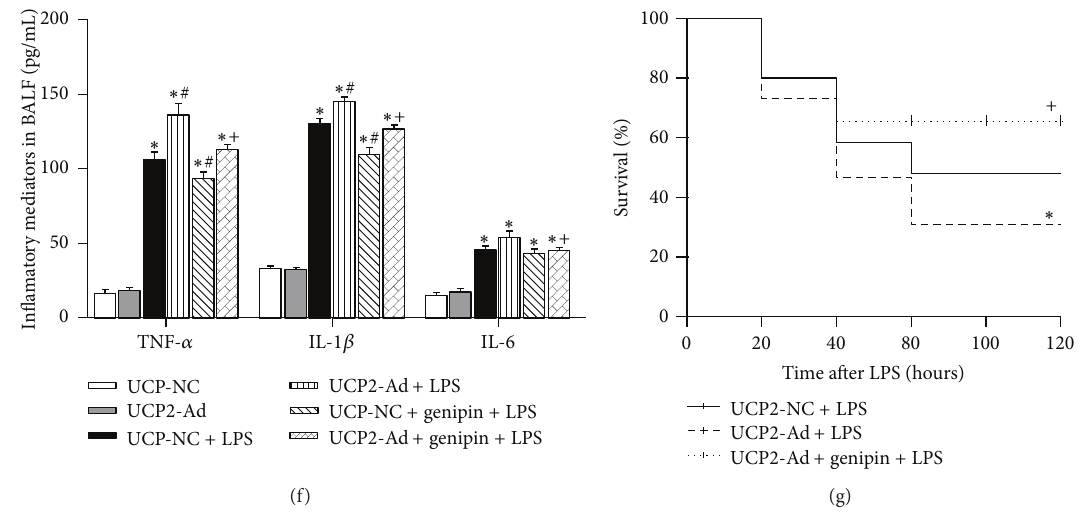
Figure 2: Effects of UCP2 on LPS-induced inflammatory lung injury, pulmonary edema, and survival rate. Mice were pretreated with UCP2-Ad, control virus (UCP2-NC), or genipin following injected LPS or saline. (a) Lungs from each group were processed for histological examination after H&E staining (400x). (b) Lung injury score in each group ( 𝑛 = 5 ). (c) The 𝑊/𝐷 ratio ( 𝑛 = 5 ). (d) Total protein concentrations in BALF. (e) Total cells number in BALF. (f) The levels of TNF- 𝛼 , IL-1 𝛽 , and IL-6 in the BALF were quantified by ELISA ( 𝑛 = 5 ). (g) The comparisons of survival rate in each group ( 𝑛 = 16 ). ∗ 𝑃 < 0.05 versus UCP2-NC + saline group, # 𝑃 < 0.05 versus UCP2-NC + LPS group, and + 𝑃 < 0.05 versus the UCP2-Ad + LPS group. Values are presented as means ±